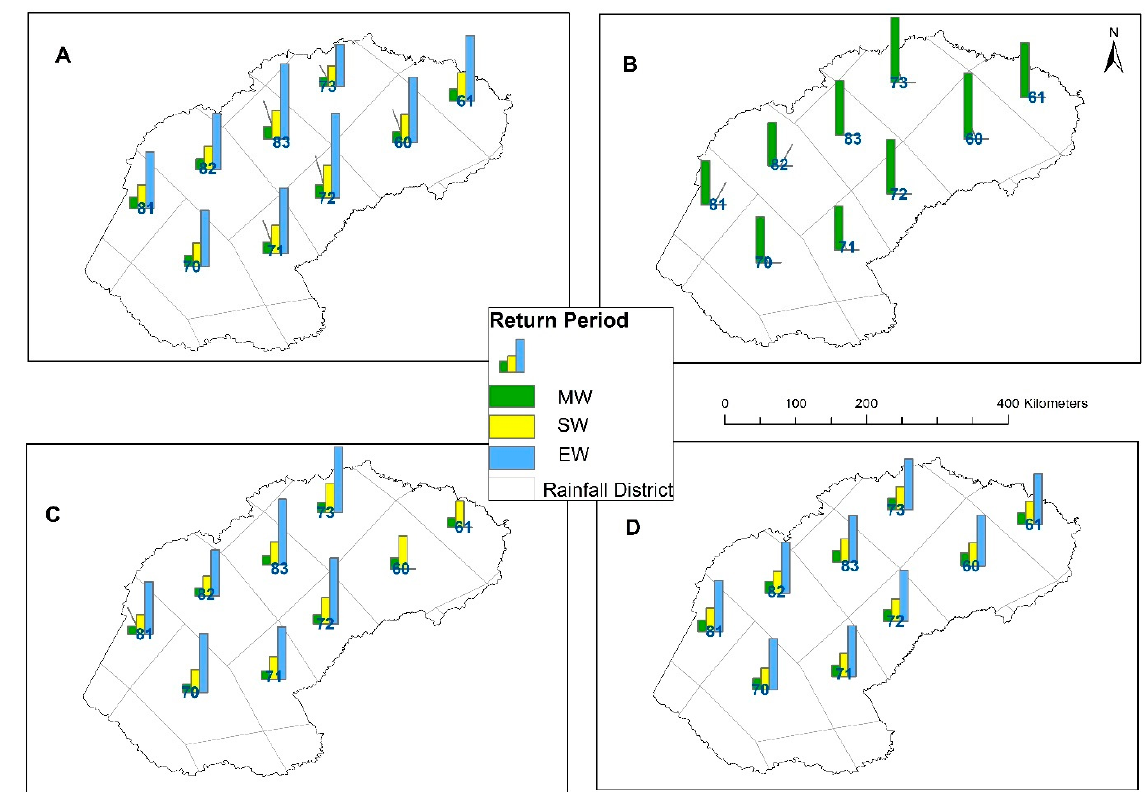
Figure 11. Return period based on the extreme frequency analysis for wet period in the Free State Province: ( A ) EDI; ( B ) SPI-3; ( C ) SPI-6; ( D ) SPI-12, from 1980 to 2019 (MW, moderately wet; SW, severely wet; EW, extremely wet).